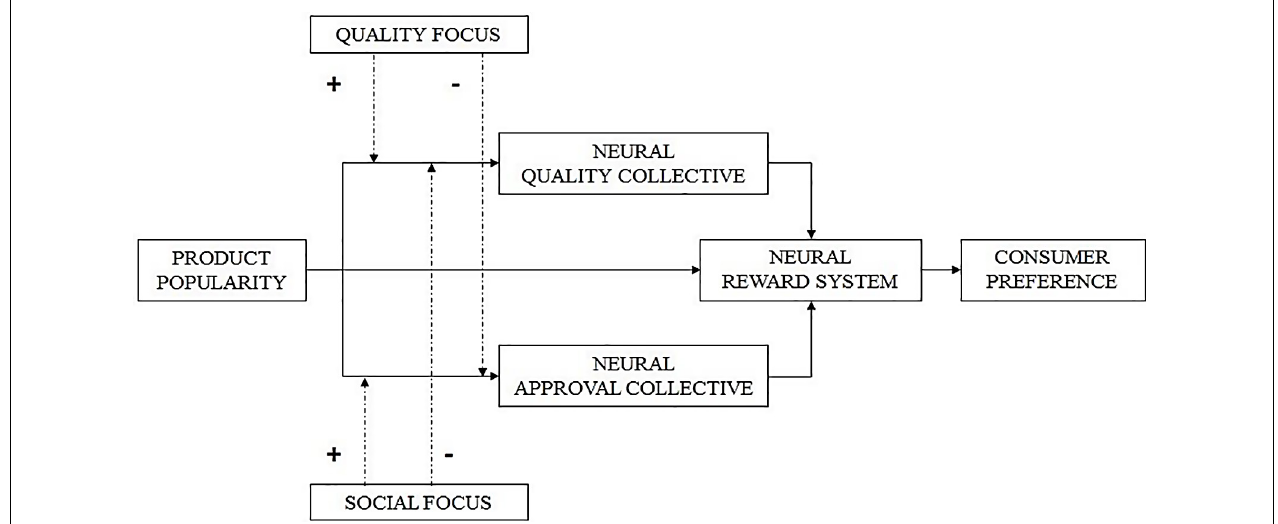
FIGURE 1 | Conceptual framework. The effect of product popularity on consumer preference is mediated by inferences of quality, reflected by activity in the neural quality collective, inferences of social approval, reflected by activity in the neural approval collective, and activity in the neural reward system. The magnitude of the mediating effect is dependent upon the focus